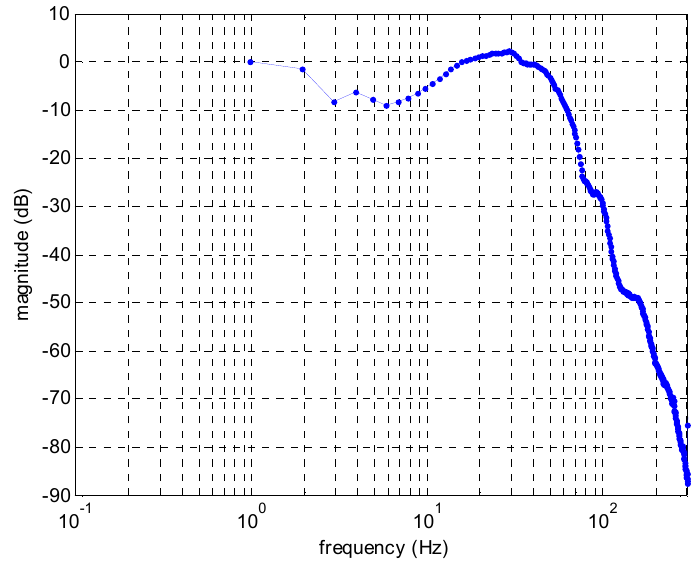
Figure 4. Frequency response of the MSM actuator.